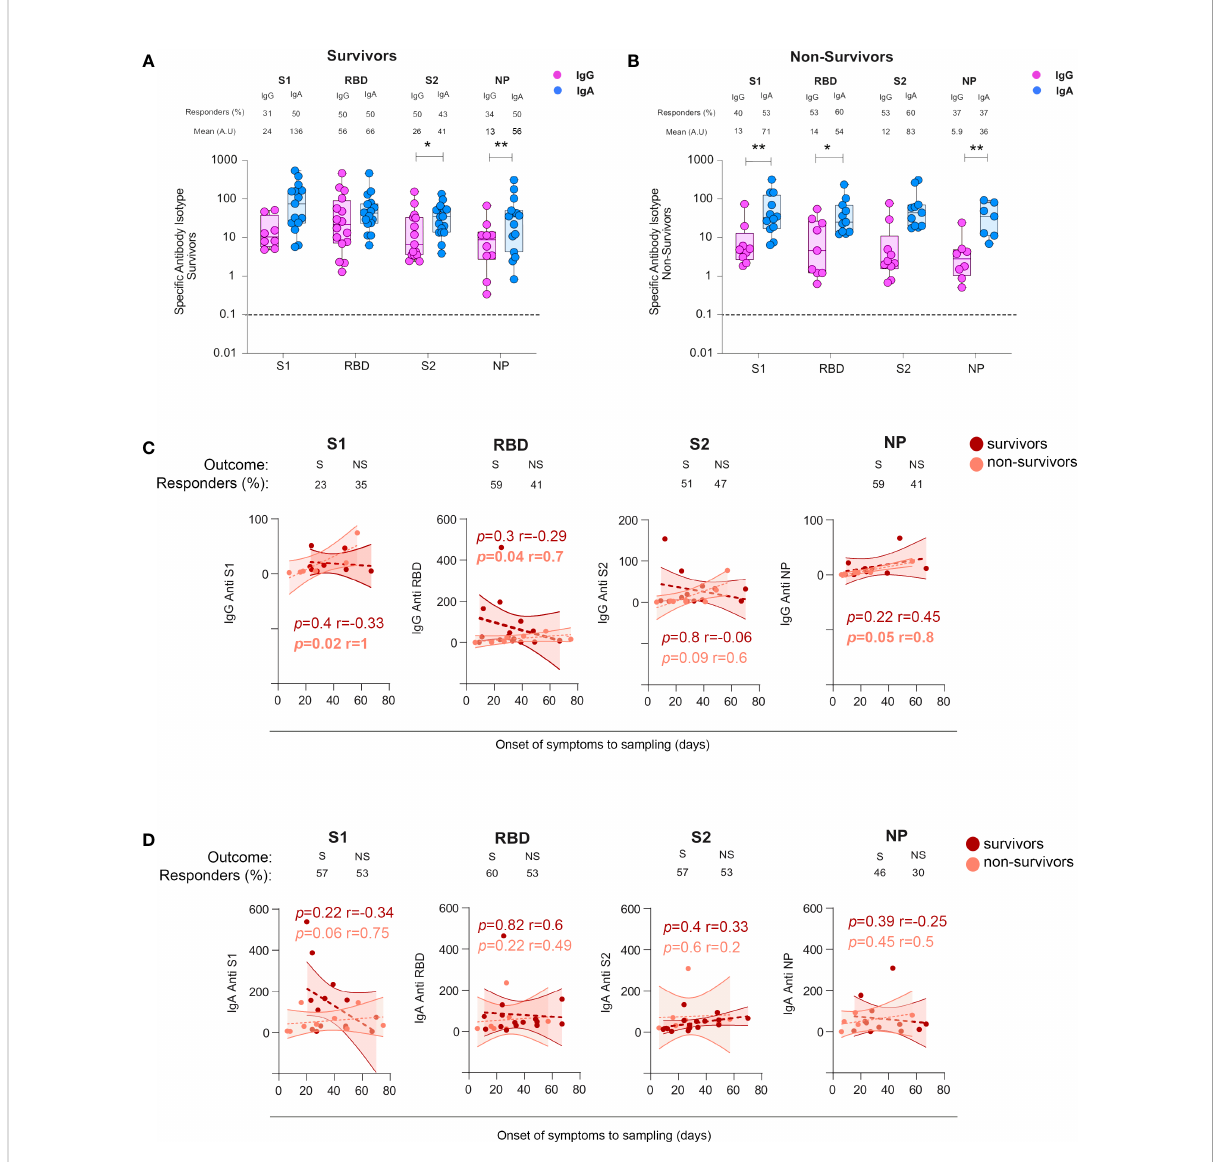
FIGURE 6 Speci fi c IgG and IgA responses in COVID-19+ survivors vs non-survivors. (A) Speci fi c S1-, S2-, RBD-, and NP-speci fi c IgG and IgA responses in survivors and non-survivors. p -Values were calculated by using Wilcoxon test (A, B) Dashed line: cutoff value for antibody detection. (C) Comparison of the kinetics from the cross-sectional SARS-CoV-2-speci fi c IgG responses in survivors (S) versus non-survivors (NS). (D) Comparison of the kinetics from the cross-sectional SARS-CoV-2-speci fi c IgA responses in survivors (S) versus non-survivors (NS). All correlations were calculated using Spearman ’ s test. *, p < 0.05; **, p < 0.01. RBD, receptor-binding domain; NP, nucleocapsid